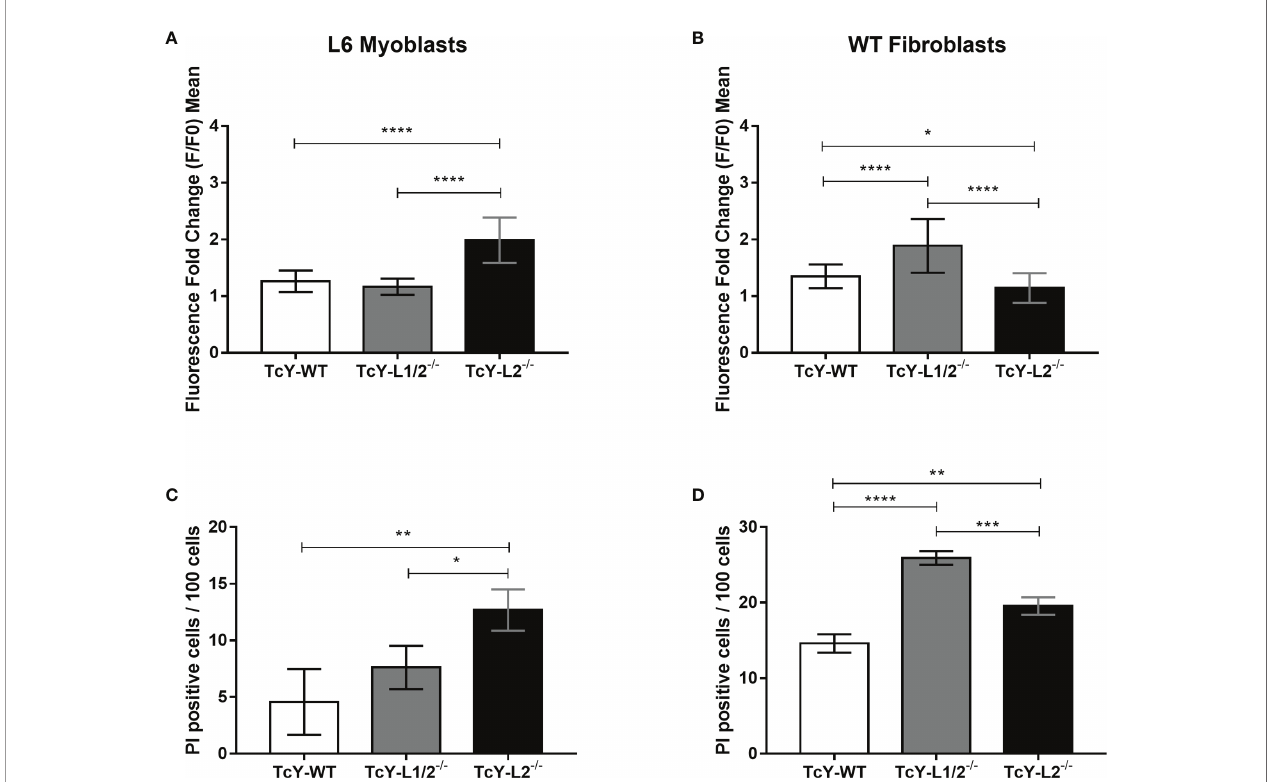
FIGURE 2 | Parasites derived from WT or LAMP de fi cient cells differ in their ability in triggering host calcium signaling events, and these differences correlate, in part, with their ability to inducing microinjuries in the host cell plasma membrane. L6 myoblasts or WT fi broblasts were exposed to TcY-WT, TcY-L1/2 − / − , and TcY-L2 − / − trypomastigotes as described in Materials and methods . Calcium signaling assays in L6 myoblasts (A) and WT fi broblasts (B) ; the cells were also exposed to ionomicin as positive control and culture medium as negative control. Membrane injury assays in L6 myoblasts (C) and WT fi broblasts (D) . Asterisks represent statistical difference between groups (*p < 0.05, **p < 0.01, ***p < 0.001, ****p < 0.0001, one-way ANOVA, Fisher ’ s